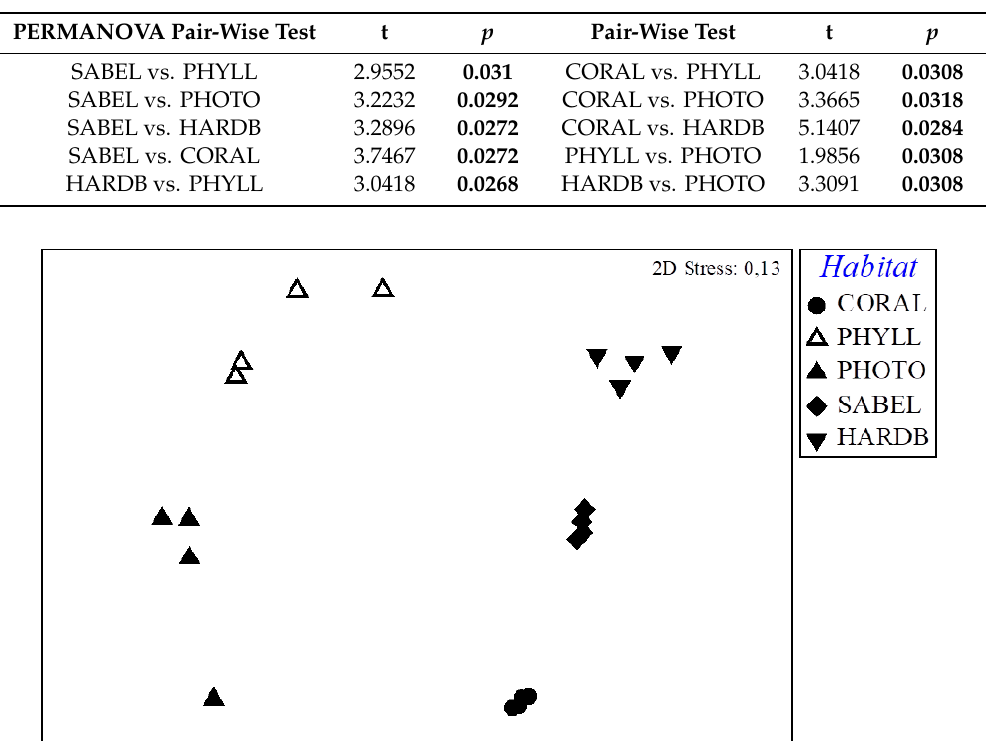
Table 3. Results of PERMANOVA pair-wise test of mollusc assemblages among the five habitats. Significant values are highlighted in bold.